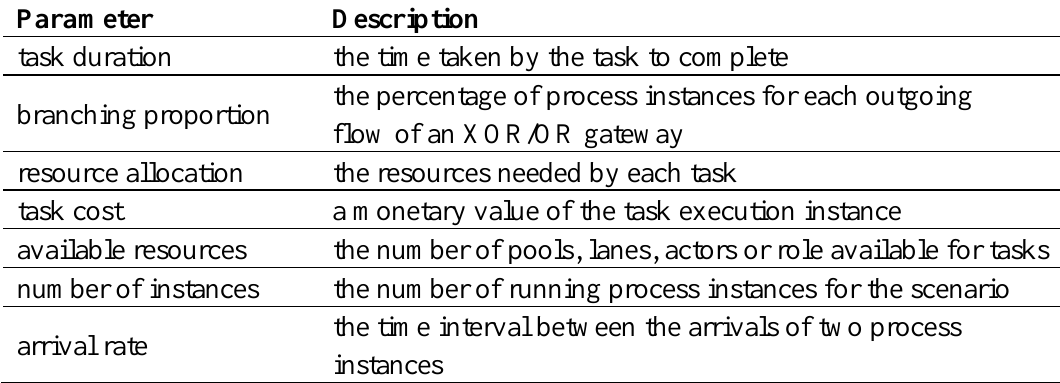
Table 1. Basic simulation parameters.